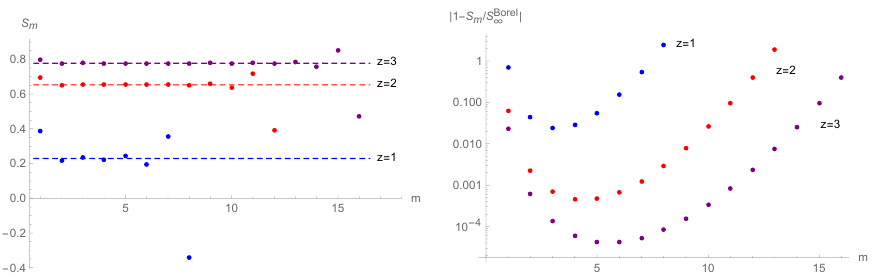
Figure 5. The ( left ) panel shows the divergence of the asymptotic sum S m ( z ) . We set ν = 1/3, α = 3/2 and z = 1,2,3. The dashed lines represent the values of the Borel sum S Borel ∞ ( z ) . The Borel sum gives the “true value” of the formal divergent sum S ∞ ( z ) . The ( right ) panel shows the optimal order of S m ( z ) . Beyond this order, S m ( z ) gets away from the “true value” S Borel ∞ ( z )